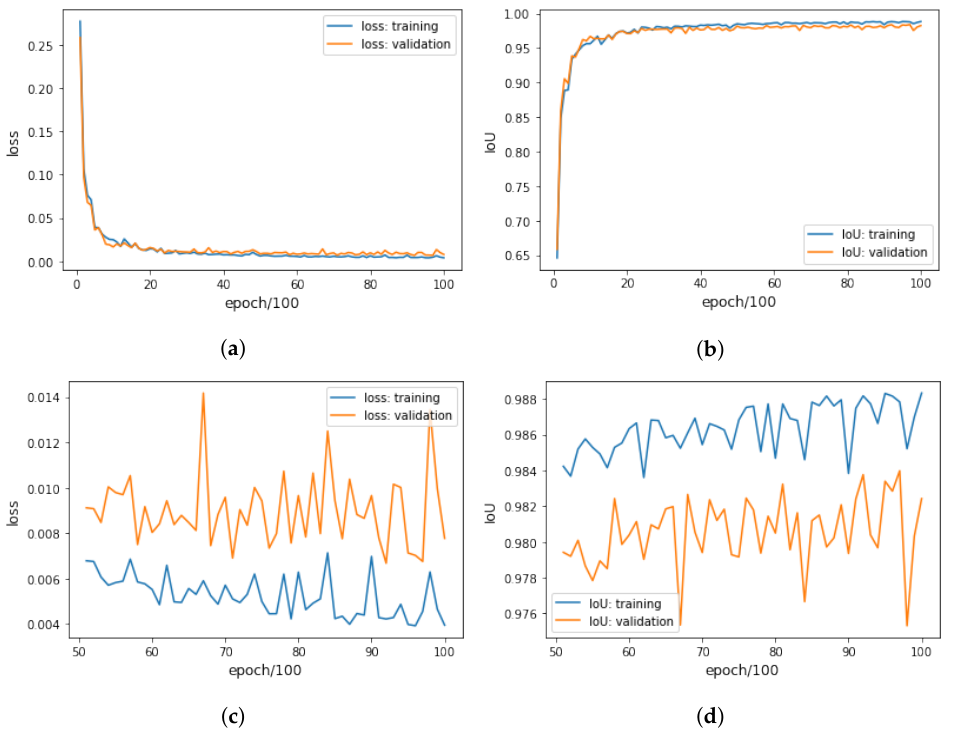
Figure 3. Training CROP with the training dataset (80%: 137) and the validation dataset (20%: 35) of Data_Fruit , so that the best IoU for the validation data was 0.984 at epoch 9700. ( a ) Losses for epoch 100–10,000. ( b ) IoUs for epoch 100–10,000. ( c ) Losses for the last half; epoch 5100–10,000. ( d ) IoUs for the last half; epoch 5100–10,000.